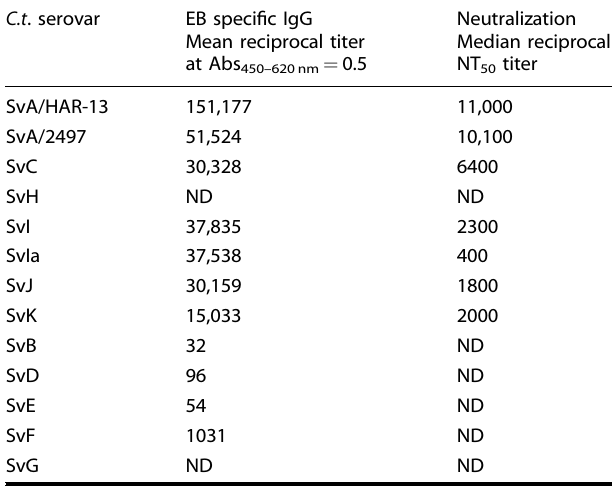
ND not detectable. Neutralization titers are the median titer of 2 – 4 experiments.